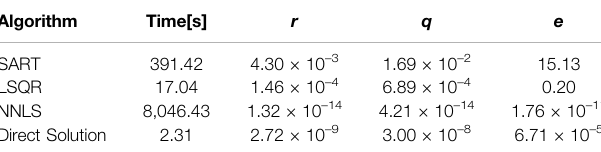
TABLE 1 | The comparison of reconstruction performance of different algorithms.